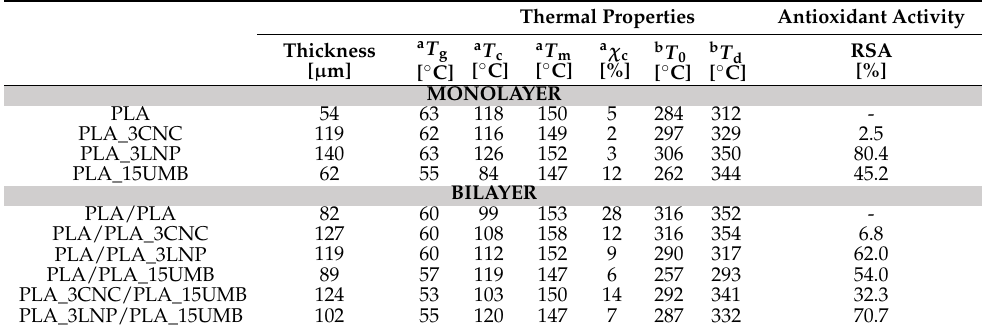
Table 2. Thermal and antioxidant characterization data of PLA (neat and nanocomposites) monolayer and bilayer films, including glass-transition temperature ( T g ), crystallization temperature ( T c ), melting temperature ( T m ), degree of crystallinity ( χ c ), thermal degradation temperatures ( T 0 and T d ) and DPPH radical scavenging activity (RSA) (time = 1